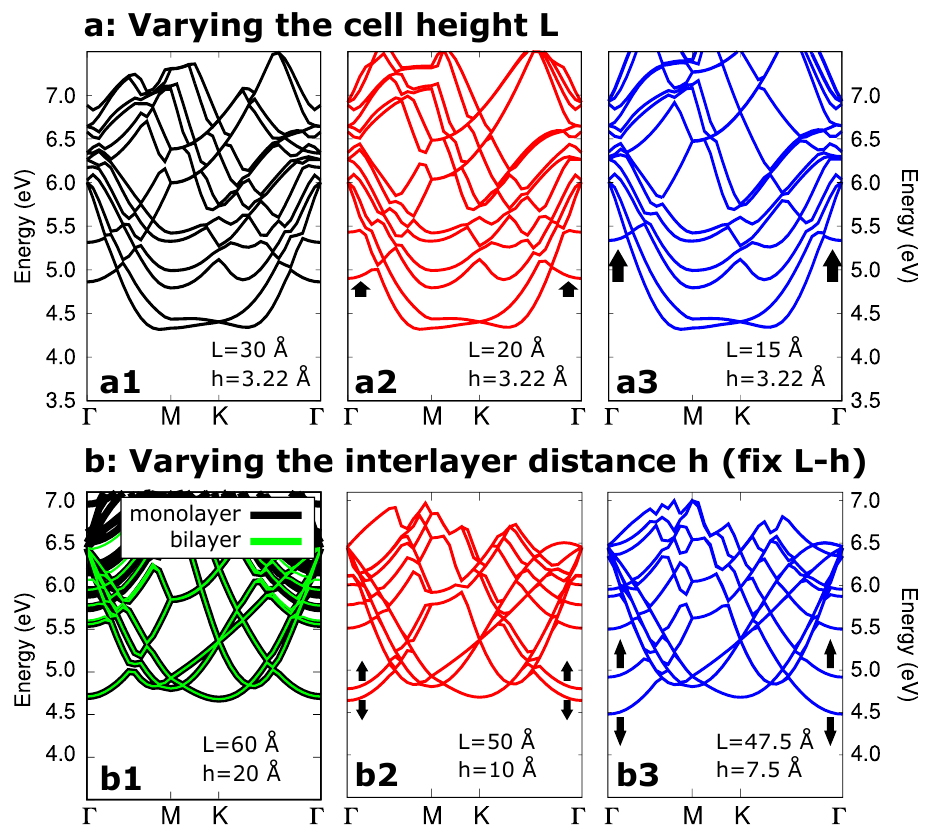
Figure 13: The evolution of the NFE states as a function of the simulation parameters in the BN(1,2) bilayer. a : evolution as a function of the cell height L at fixed interlayer dsitance ( h = 3.22 Å). L = 30, 20 and 15 Å in panels a1 , a2 and a3 respectively. b : evolution as a function of the interlayer dsitance h at fixed vacuum ( L − h = 40 Å). h = 20, 10 and 7.5 Å in panels b1 , b2 and b3 respectively. In panel b1 , the band structure of the BN(1,2) bilayer (flashy green) is compared with that of the isolated monolayer